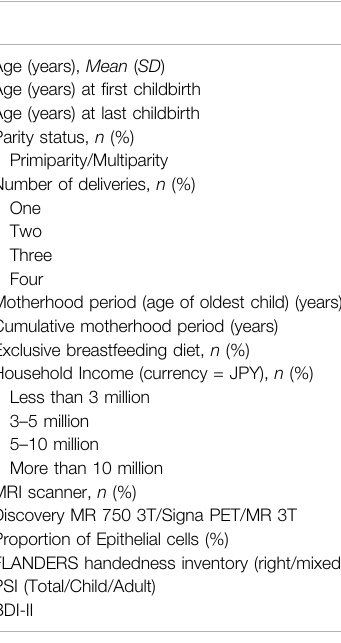
TABLE 1 | Demographic characteristics of the